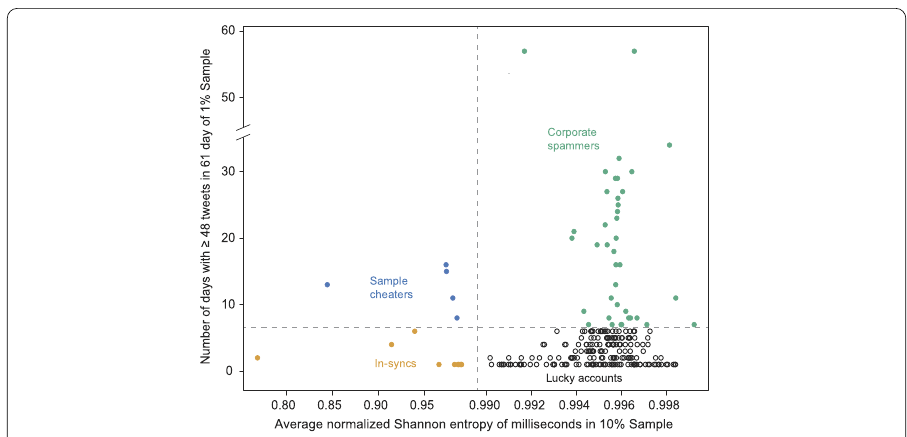
Figure 5 Types of over-represented accounts. 249 of the 1000 accounts with the most Tweets in the 1% Sample. Blue: Sample cheaters. Accounts with low entropy score and many days with ≥ 48 Tweets/day are defined as likely cheaters. Green: Corporate spammers. Accounts over-represented on many days but without suspicious entropy scores; all of these accounts can be linked to commercial activity. Yellow: In-syncs. Frequency bots that are temporarily synced with the sampling mechanism. Black: Lucky accounts that are randomly over-represented but show no suspicious